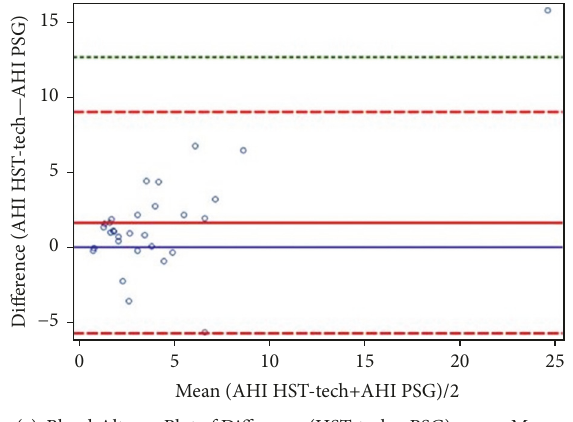
(a) Bland-Altman Plot of Difference (HST-auto—HST-tech) versus Mean.